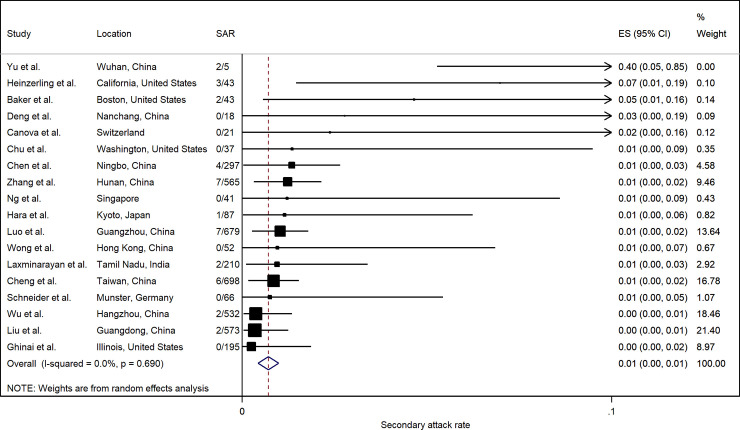
Forest plot of household transmission risk by adult and children close contact.RR is the estimated risk ratio, with 95% confidence intervals (CI). I-squared is the percentage of between-study heterogeneity that is attributable to variability in the true effect, rather than sampling variation.